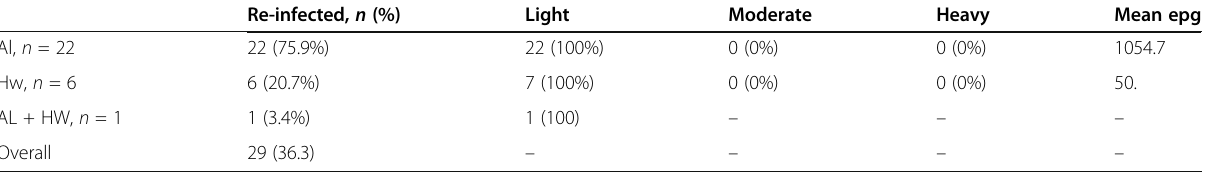
Table 3 Intensity of STH infection among re-infected schoolchildren in Northwest Ethiopia, n = 80